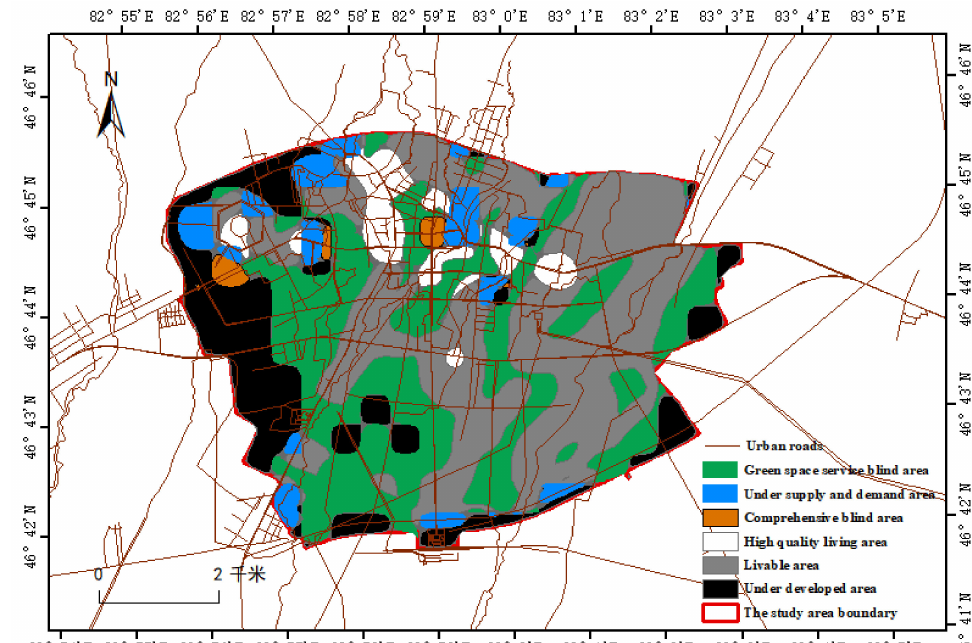
Figure 5. Comprehensive analysis